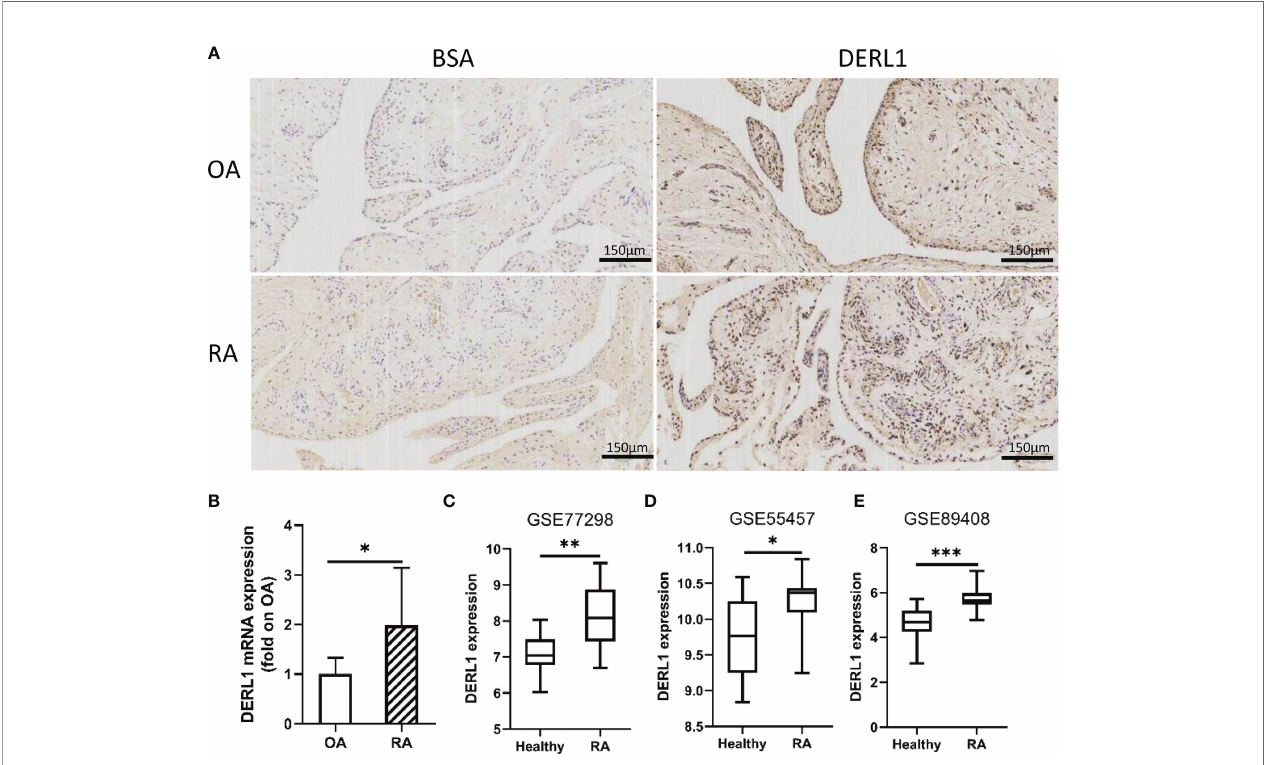
FIGURE 7 | The expression of DERL1 in OA and RA synovial tissues. (A) The expression of DERL1 in RA and OA synovial tissue was detected with immunohistochemistry tests. (B) The mRNA of DERL1 in RA and OA synovial tissue was detected with real-time PCR. (C – E) The expression of DERL1 in GSE77298 dataset, GSE55457 dataset, and GSE89408 dataset. Student ’ s-t test with Welch ’ s correction was used for the data analyses in (B) . Student ’ s-t test was used for the data analyses in (C, D) . The Mann-Whitney test was used for the data analyses in (E) . * P < 0.05, ** P < 0.01, *** P <